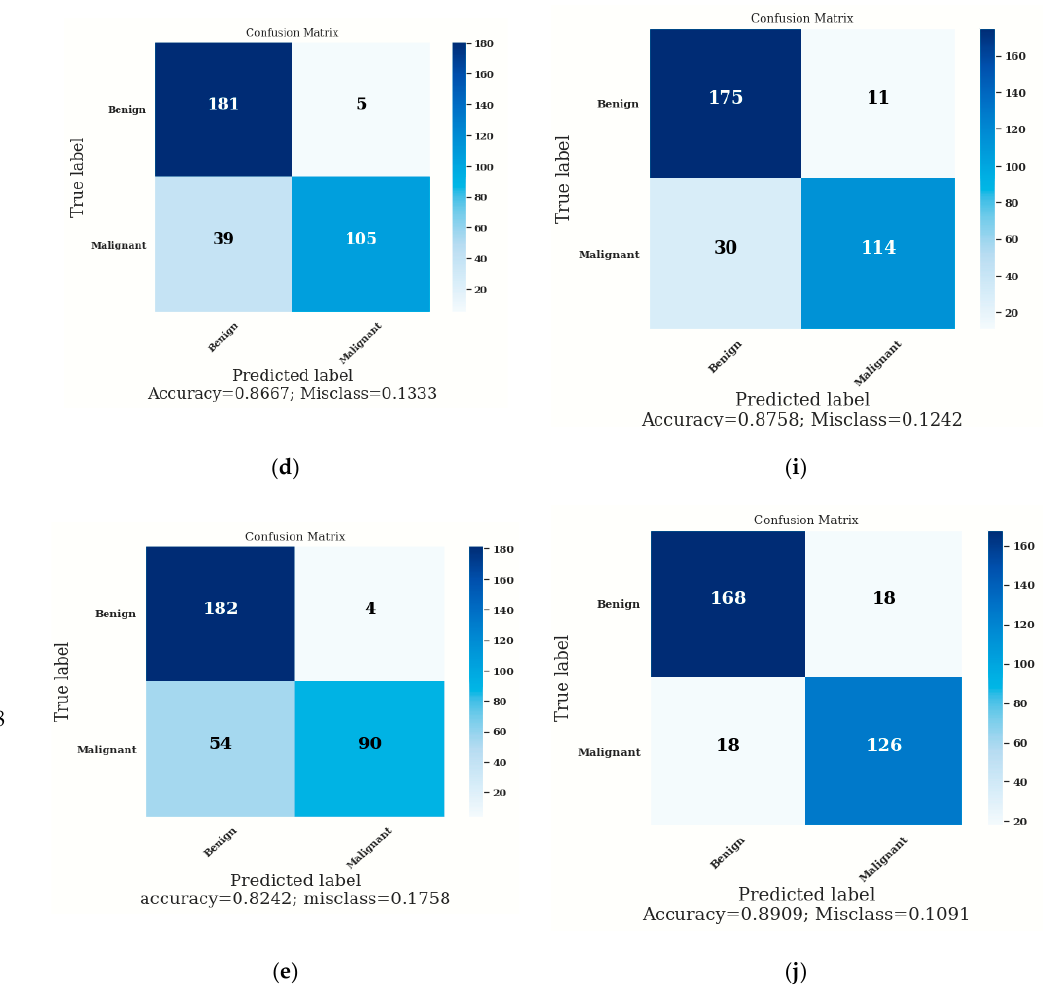
Figure 8. Confusion Matrix for VGG16 on Batch Size ( a ) 8 ( b ) 16 ( c ) 32 ( d ) 64 ( e ) 128, Confusion Matrix for Modified VGG16 on Batch Size ( f ) 8 ( g ) 16 ( h ) 32 ( i ) 64 ( j ) 128.